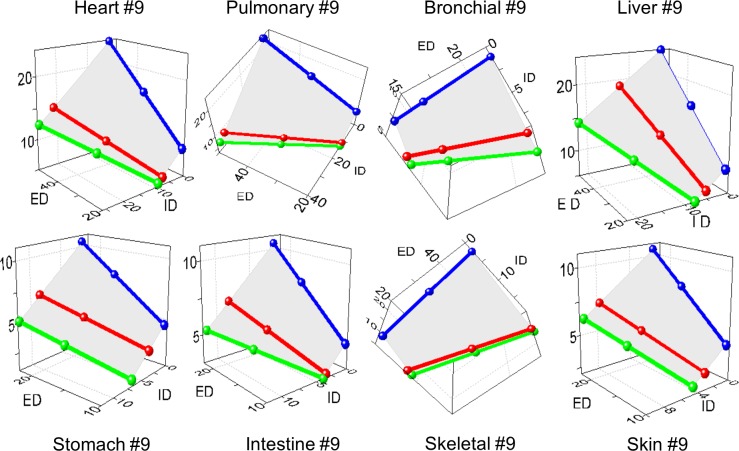
The common remodeling variant in hypertensive rats.The same variant #9 was found in most organs. Axis X–external diameter ED; axis Y–internal diameter (ID); axis Z–wall thickness (WTh), μm.